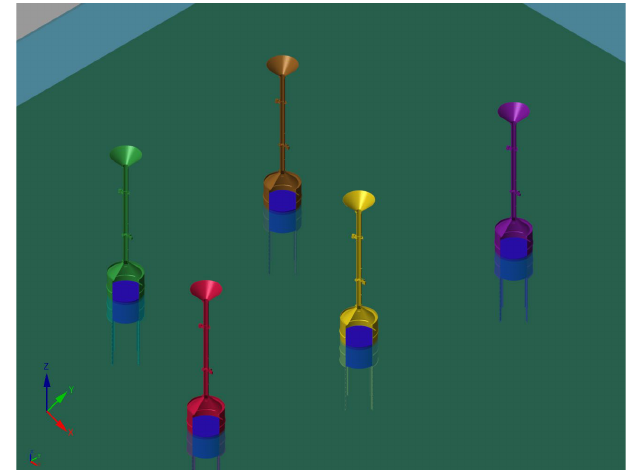
Fig. 3. WEC-Sim Non-optimal array layout. Blue cylinders are hydrodynamic bodies. Multi-colored bodies are for visualization